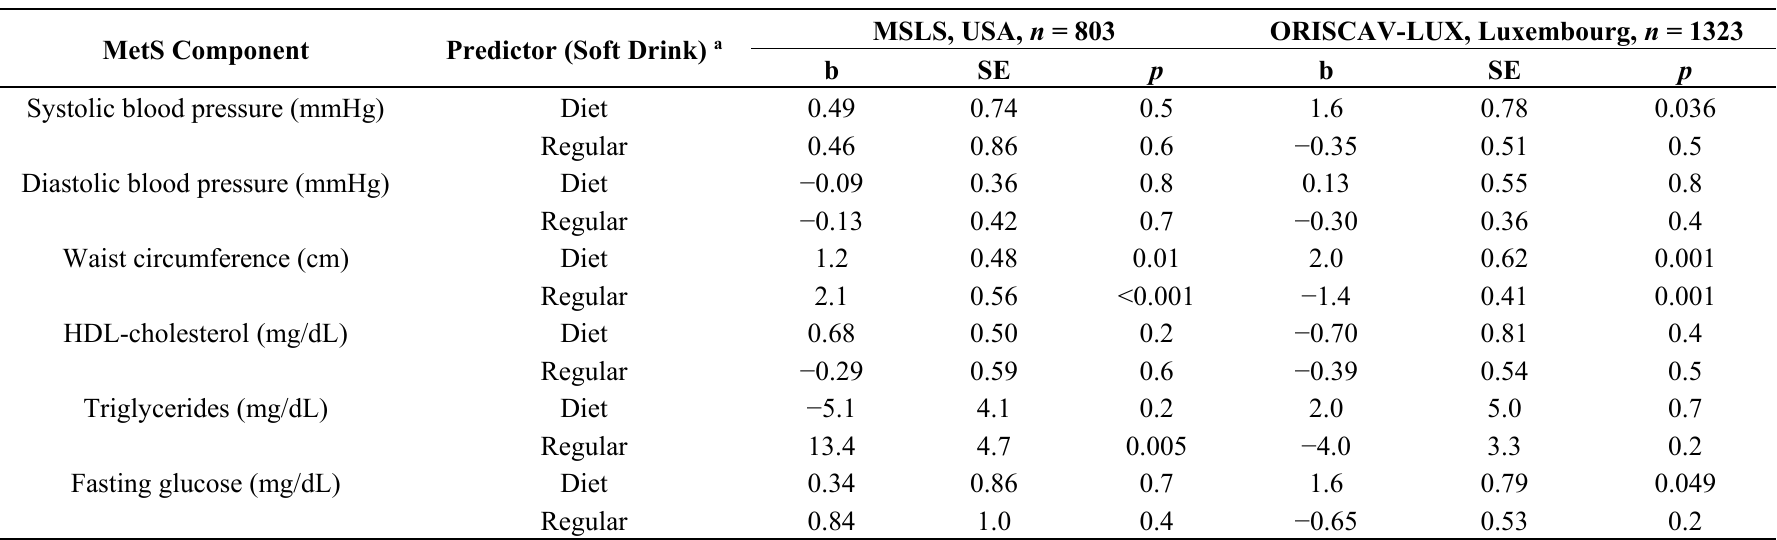
Table 4. Cross-sectional relationships between soft drink consumption and MetS components in MSLS and ORISCAV-LUX. MetS